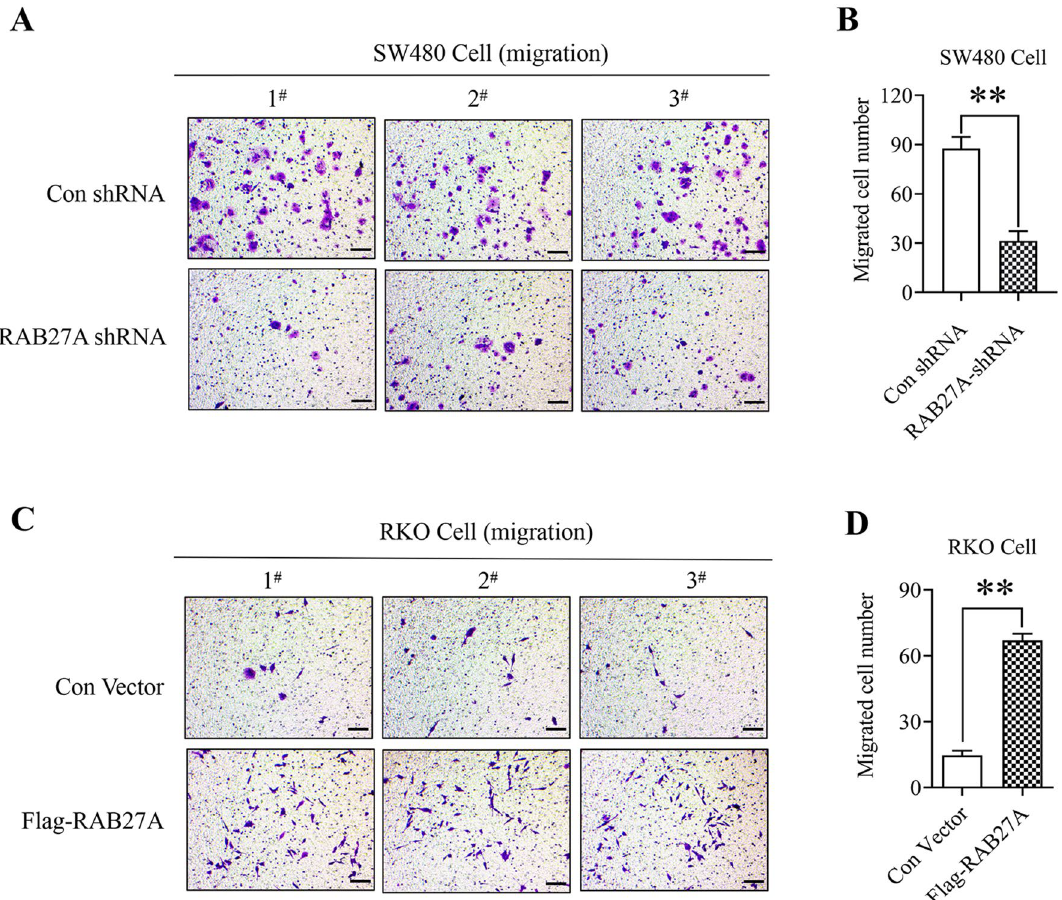
Figure 4. The effect of RAB27A on colon cancer cell migration. ( A ) and ( B ). RAB27A knockdown suppresses the migration of SW480 cells. RAB27A knockdown and the negative control SW480 cells were seeded in the upper well of the Transwell chamber for 48 h, and the migrated cells were stained with the crystal violet. ( C ) and ( D ). RAB27A overexpression facilitates RKO cell migration. RAB27A overexpression cells and the negative control cells were seeded in the upper well of the Transwell chamber for 48 h, and the migrated cells were stained with the crystal violet. Cell migration was determined by microscopy (200 ×). At least three fields in each group were observed, and the representative images were shown (scale bar = 100 µm). Migrated cell number in each field was shown as mean ± S.D. and was analyzed by two-tailed t-test. And the value of the vertical axes in this figure is migrated cell number per field of view. ** P < 0.01. All the experiments were repeated three times independently and the representative results were